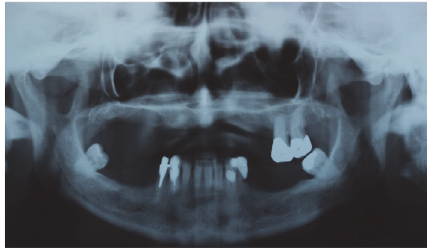
Figure 2: Panoramic radiograph from the initial examination.